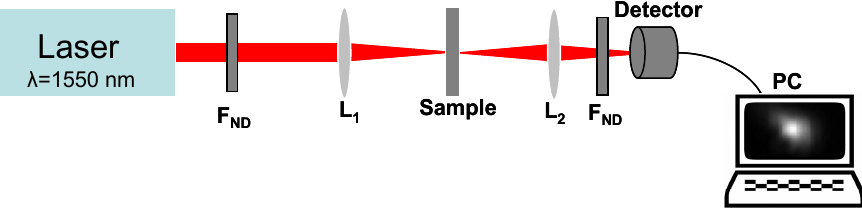
Figure 17. Schematic of the experimental setup for optical limiting (OL) studies.